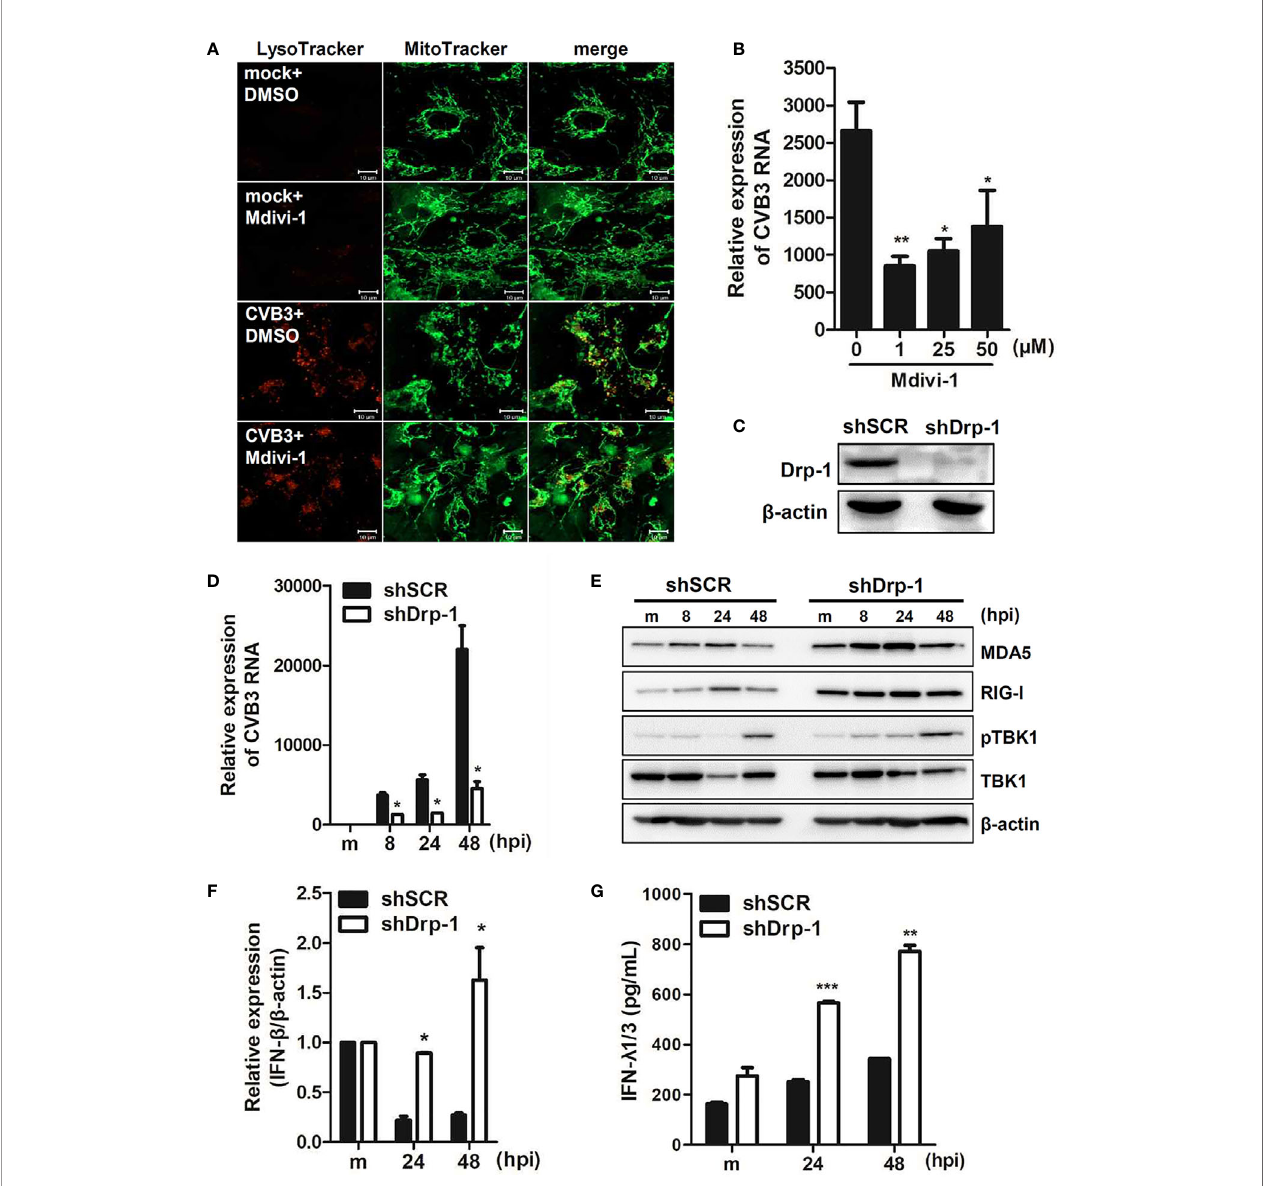
FIGURE 4 | Mitochondrial fi ssion is important for CVB3 replication (A) hNPCs were treated with DMSO control or 25 m M Mdivi-1 for 2 h and infected with mock or CVB3 (48 hpi, MOI=5). The cells were subsequently stained with MitoTracker Green and LysoTracker Red. Scale bar = 10 m m. (B) hNPCs were pre-treated with different doses of Mdivi-1 for 2 h and infected with CVB3 at an MOI of 5 for 48 h. CVB3 vRNA expression was quantitated, normalized, and analyzed by quantitative realtime PCR (mean ± SD; n = 3). *p < 0.05; **p < 0.01; vs . DMSO-treated cells. (C) The knockdown ef fi ciency of Drp-1 in scrambled control shRNA (shSCR) and Drp-1-speci fi c shRNA-expressing (shDrp-1) THP-1 cells was con fi rmed by immunoblot analysis. (D – G) THP-1-shSCR and -shDrp-1 cells were infected with mock (m) or CVB3 at an MOI of 5 for the indicated time points. (D) CVB3 vRNA expression was quantitated, normalized, and analyzed by quantitative realtime PCR (mean ± SD; n = 3) (E) . The protein levels of RIG-I, MDA5, and phospho-TBK/total TBK were measured by immunoblot analysis. (F) IFN- b mRNA levels were measured by quantitative realtime PCR (mean ± SD; n = 3). (G) IFN- l 1/3 secretion levels were measured by ELISA. *p < 0.05; **p < 0.01; ***p < 0.001, compared with THP-1-shSCR cells at the indicated time